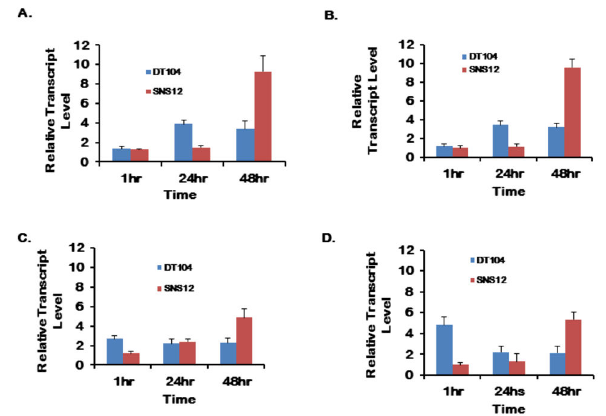
Figure 5. Antimicrobial response to wild type Salmonella Typhimurium DT104. Expression of (A) pqn-54 , (B) abu-1 , (C) abf-2 and (D) abu-11 genes of N2 worms as determined by qRT-PCR at one hour, 24-hour and 48-hour exposure. Relative expression levels (DT104 or SNS12 over OP 50) are shown as fold changes (mean ± std. err.).